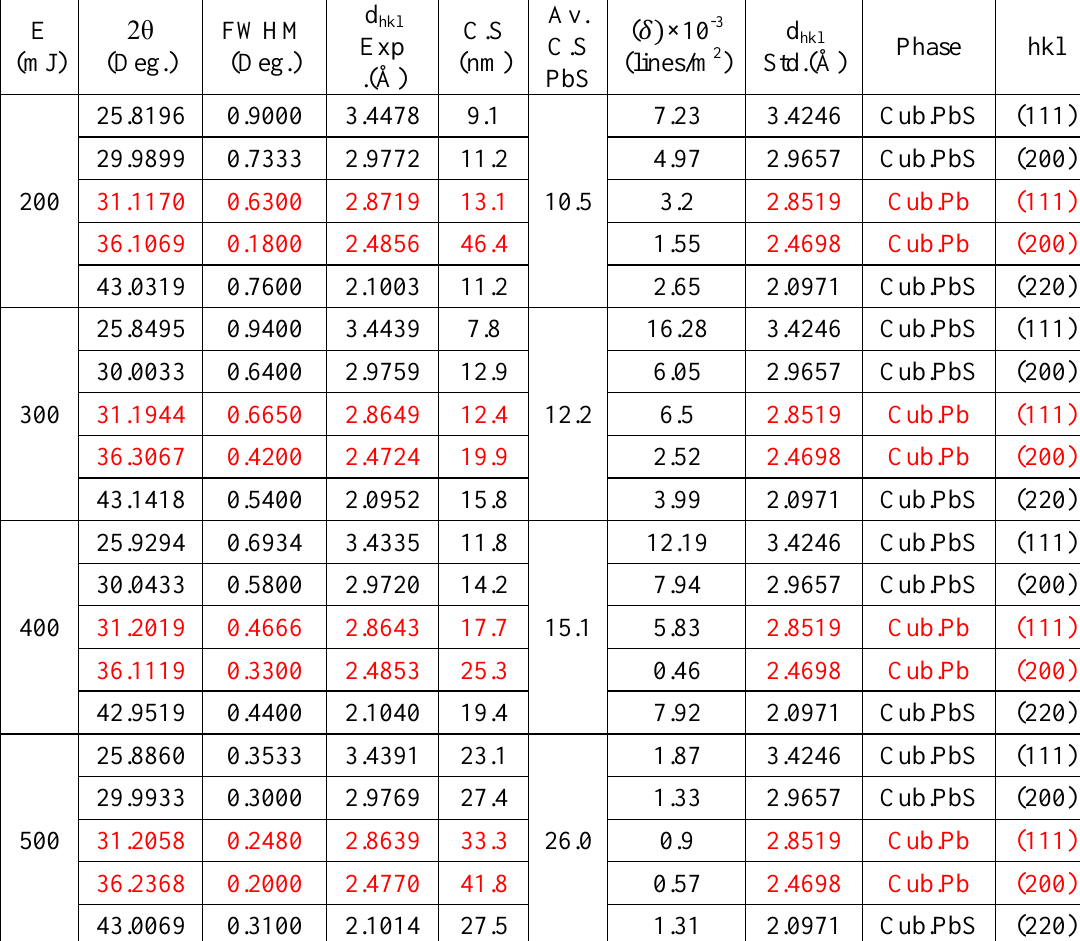
Table 1: Effect of laser energy on the structural properties of PbS